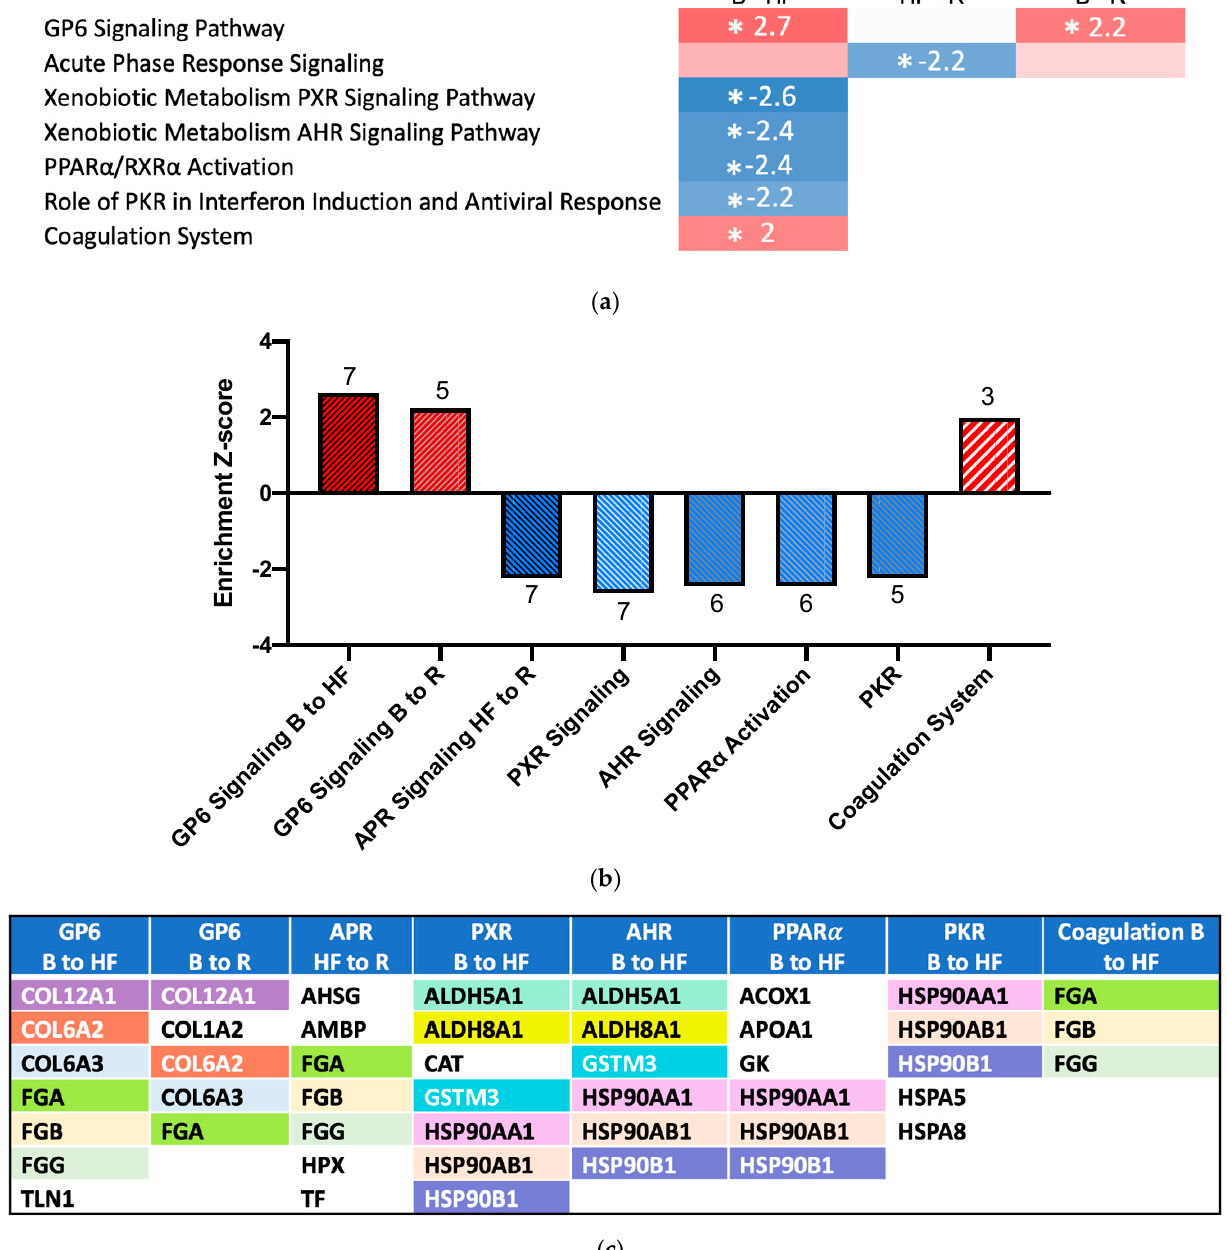
Figure 3. ( a ) Heatmap of pathway enrichment and activation/inhibition. Enrichment Z-scores are displayed in each box; red indicates a positive Z-score (activation of a pathway) while blue represents a negative Z-score (repression of a pathway). The intensity of colour represents the magnitude of the Z-score, with darker hues indicating greater scores. Starred timepoints indicate an absolute Z-score > 2 or < − 2 and an adjusted p -value < 0.01, representing enriched and activated/repressed pathways. ( b ) Enrichment Z-scores for activated/repressed pathways. The number of proteins that caused annotation to the pathway is noted directly above/below each bar. Red signifies activation of a pathway, whilst blue indicates repression. ( c ) Lists of proteins that caused annotation to the enriched and activated/repressed pathways. Colours indicate when a protein has been annotated to more than one pathway. AHR: aryl hydrocarbon receptor signalling pathway, APR: acute phase